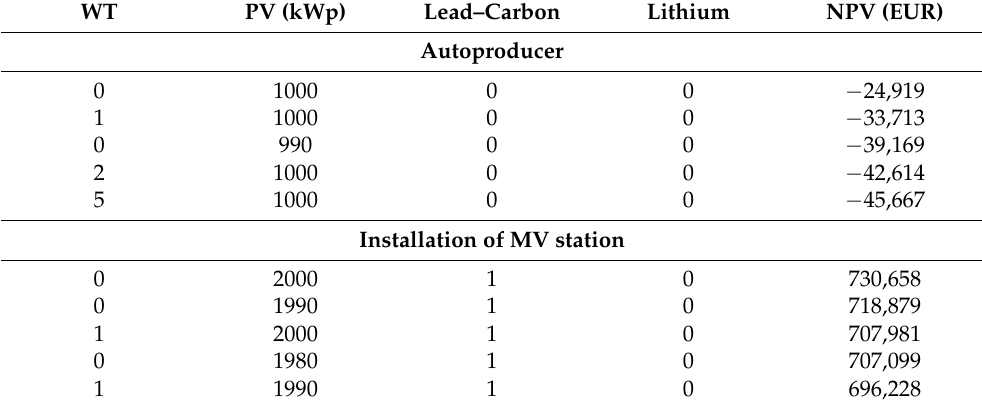
Table 9. Optimal results of the HMU campus microgrid considering 50% battery cost reduction.